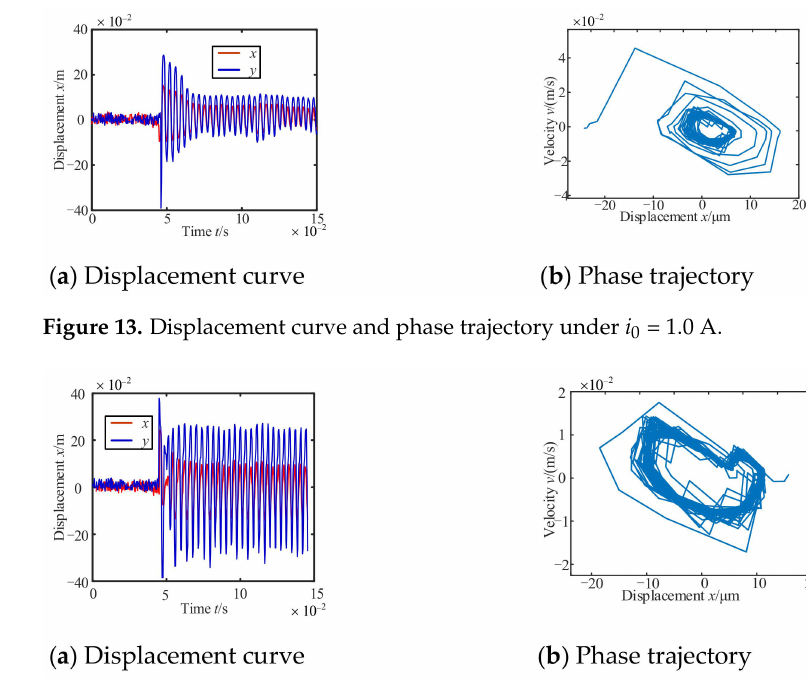
Figure 14. Displacement curve and phase trajectory under i 0 = 1.2